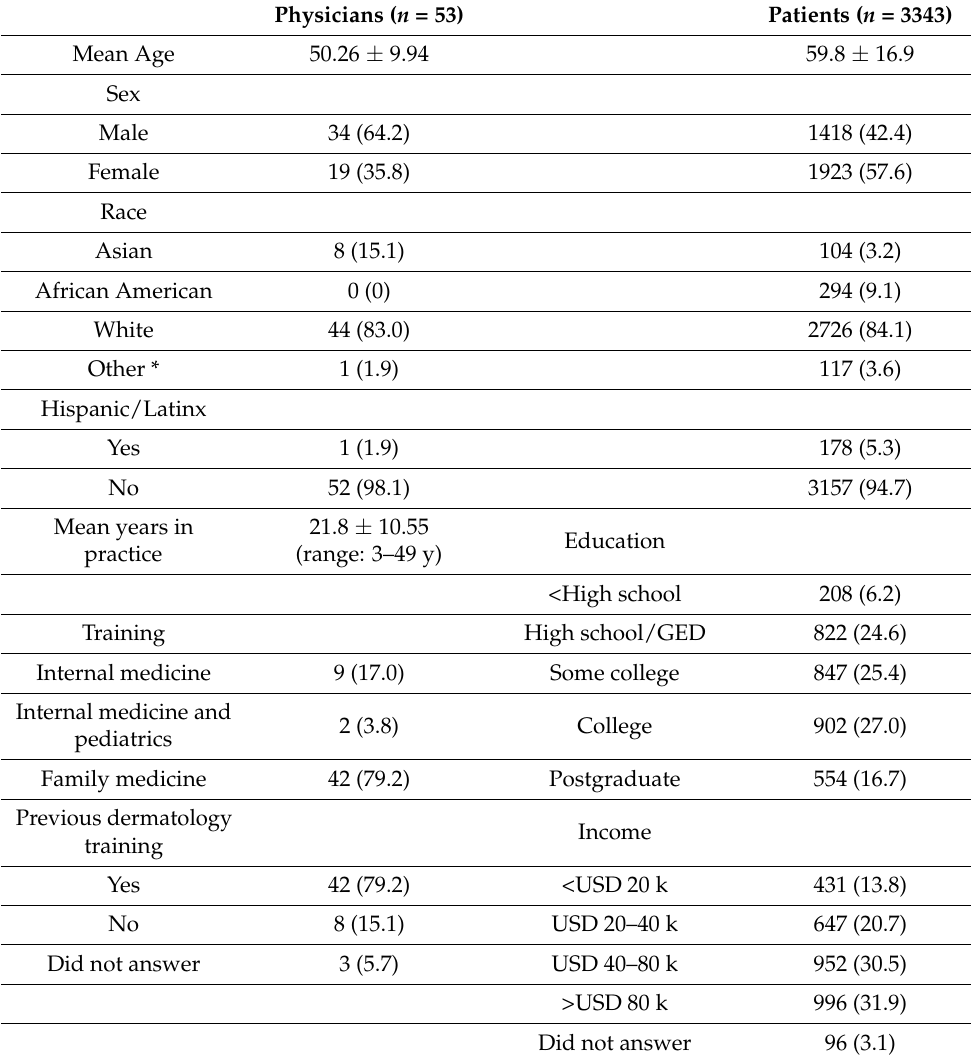
Table 1. Demographic characteristics of physicians and